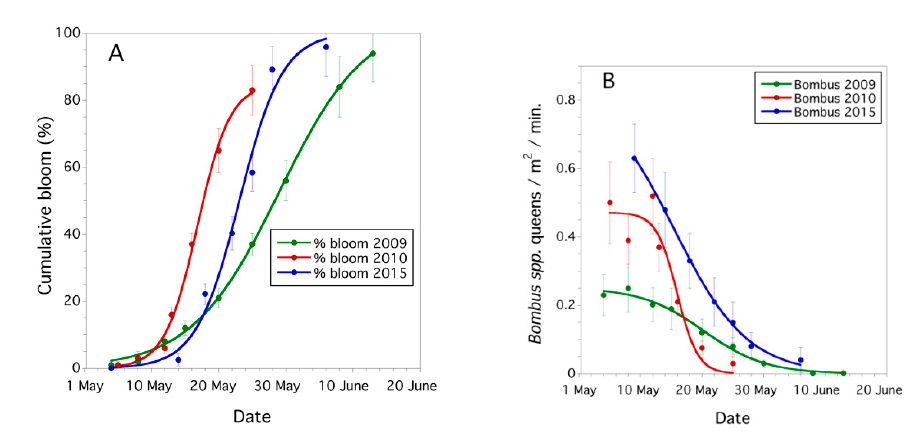
Figure 5. Wild blueberry field bloom progression and queen bumble bee activity-density over a three-year study (2009, 2010, and 2015), percent cumulative bloom ( A ) and the dilution of queen foraging intensity as bloom progresses ( B ). Error bars are standard errors. Parameters for non-linear regression lines are listed in Table 1.